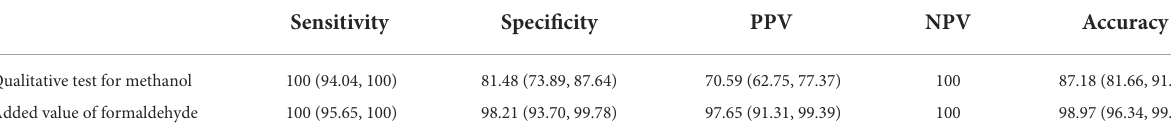
TABLE 2 Sensitivity, specificity, positive and negative predictive values of the qualitative tests compared to the gold